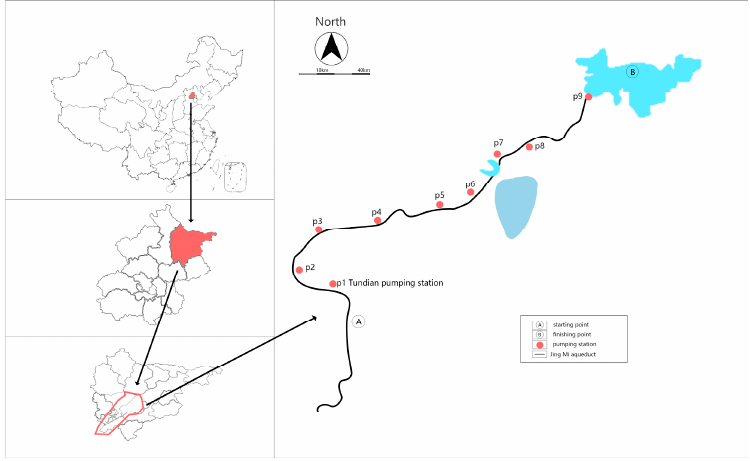
Figure 1. A schematic diagram of the Miyun Reservoir project.